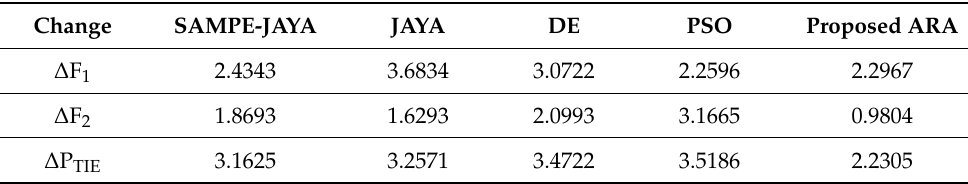
Table 5. Settling times (s) under Case Study